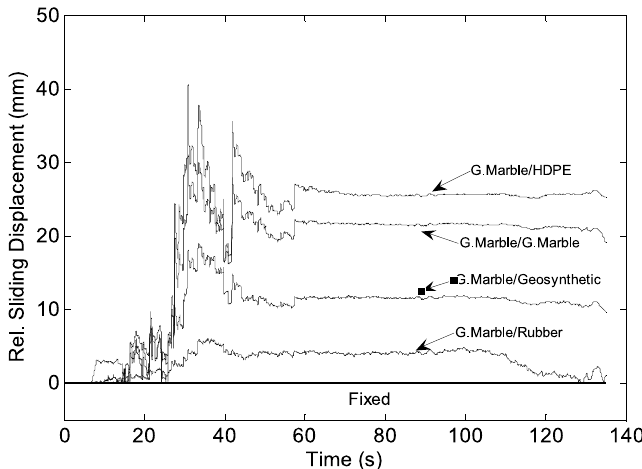
Fig. 8. Relative sliding displacement response for different sliding